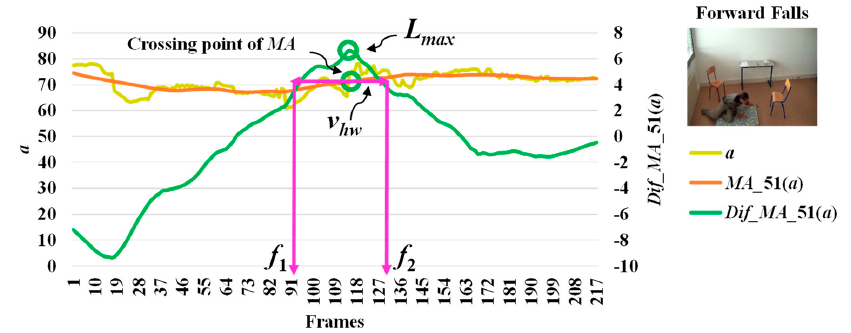
Figure 7. Analysis for a high possibility of abnormal (falling) points based on the area of the object shape ( a ) by falling forwards.